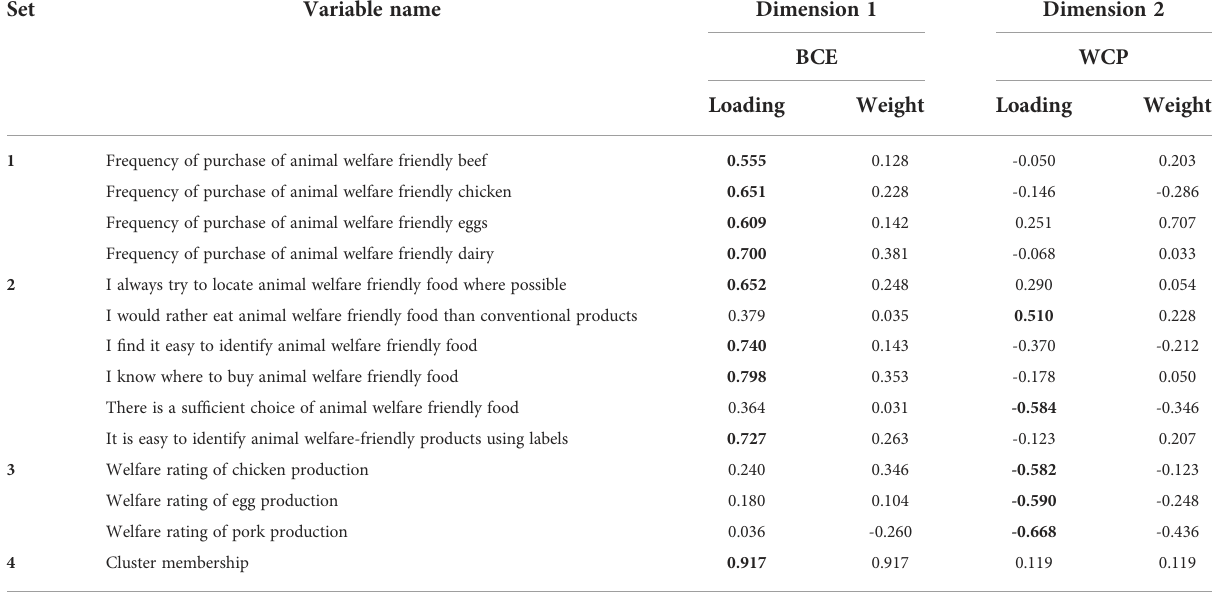
TABLE 5 Sets of variables, variables name and NLCCA dimension weights and loadings .